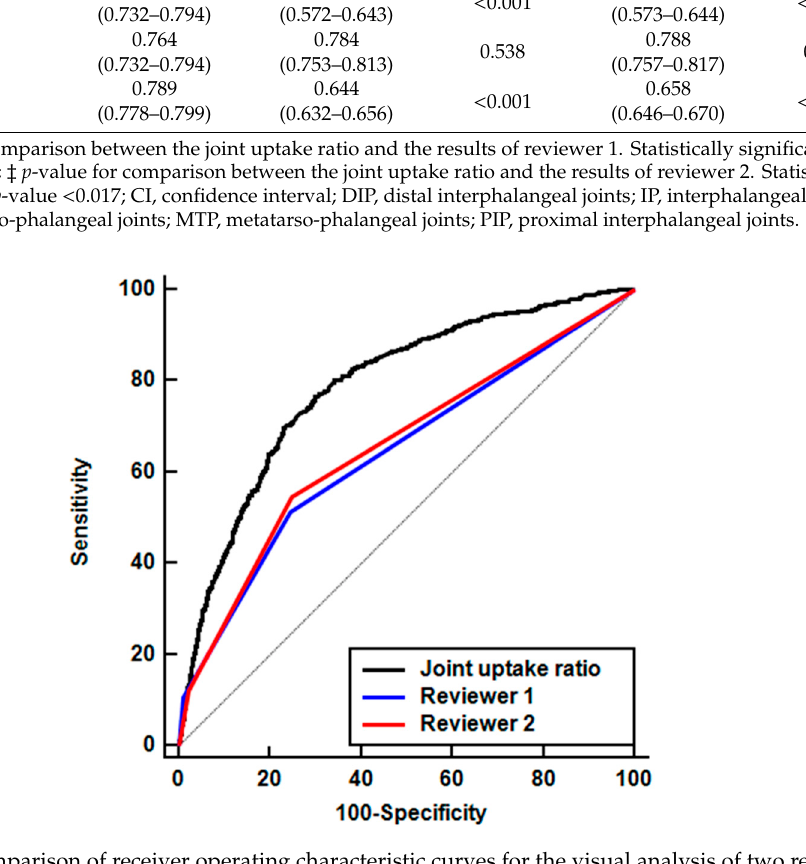
Figure 4. Comparison of receiver operating characteristic curves for the visual analysis of two readers (Reviewer 1 and Reviewer 2) and the joint uptake ratio in detecting affected joints among the 5941 joints.